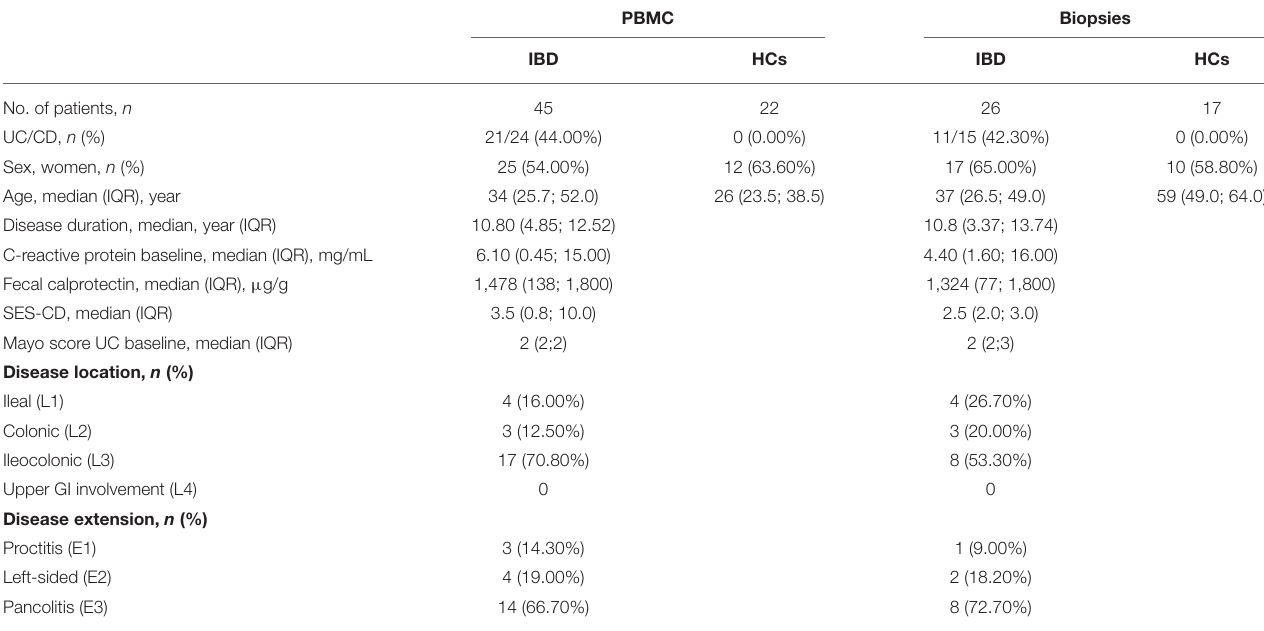
TABLE 1 | Demographic characteristics of patients with active disease and healthy controls.